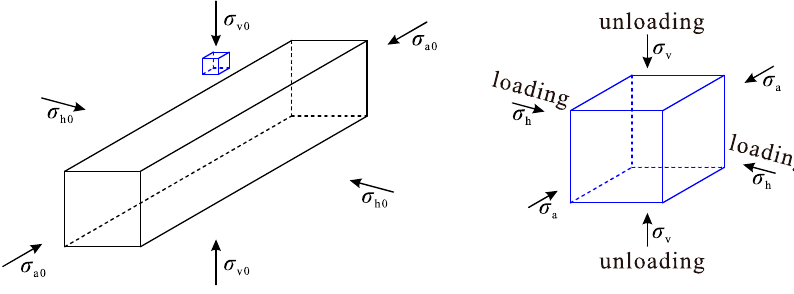
Figure 1. A rectangular tunnel and the in-situ stresses.